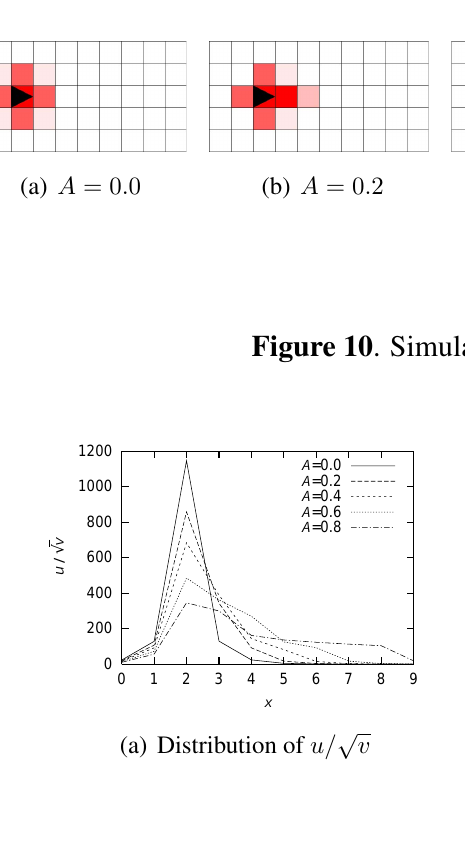
Figure 9 . Generated patterns for a moving target.